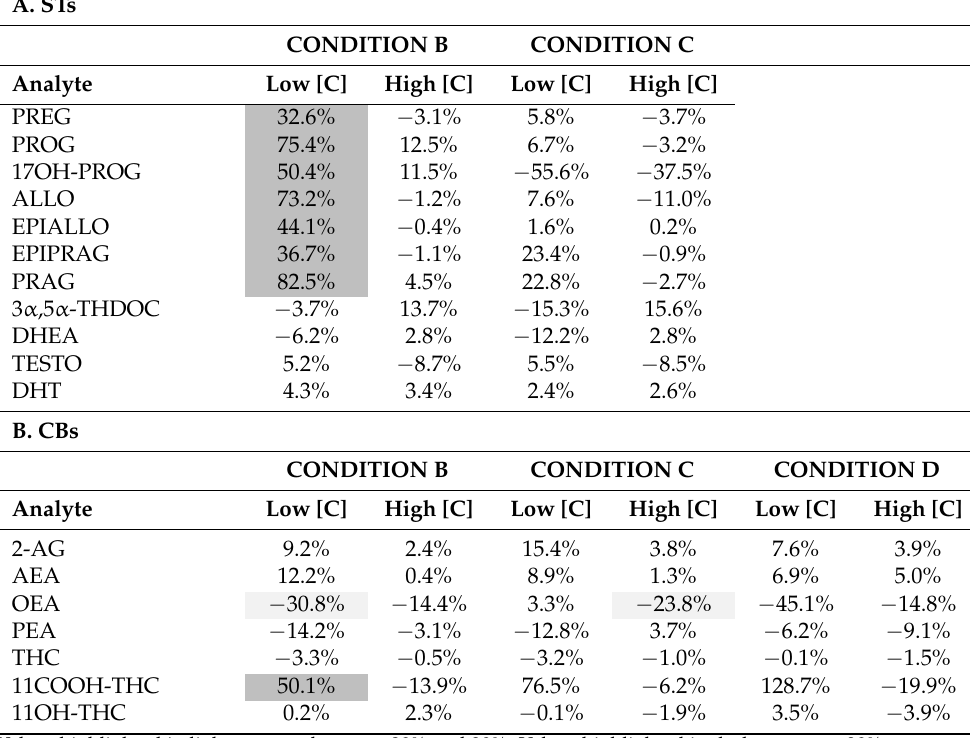
Values highlighted in light grey are between 20% and 30%. Values highlighted in dark grey are